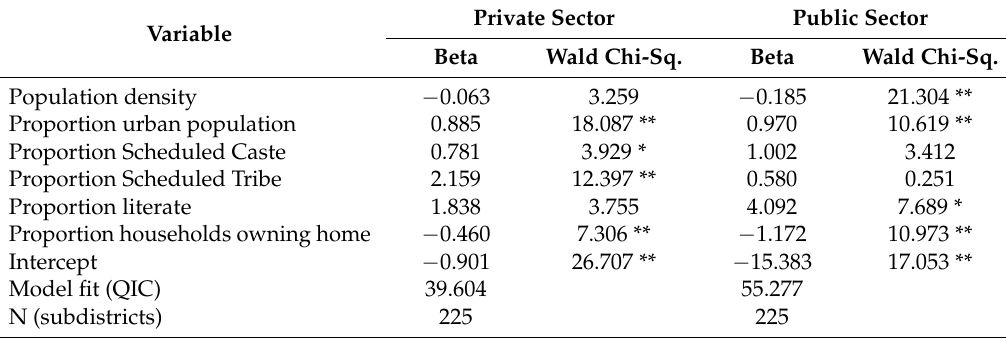
Table 5. GEEs for predicting density of MAH units by